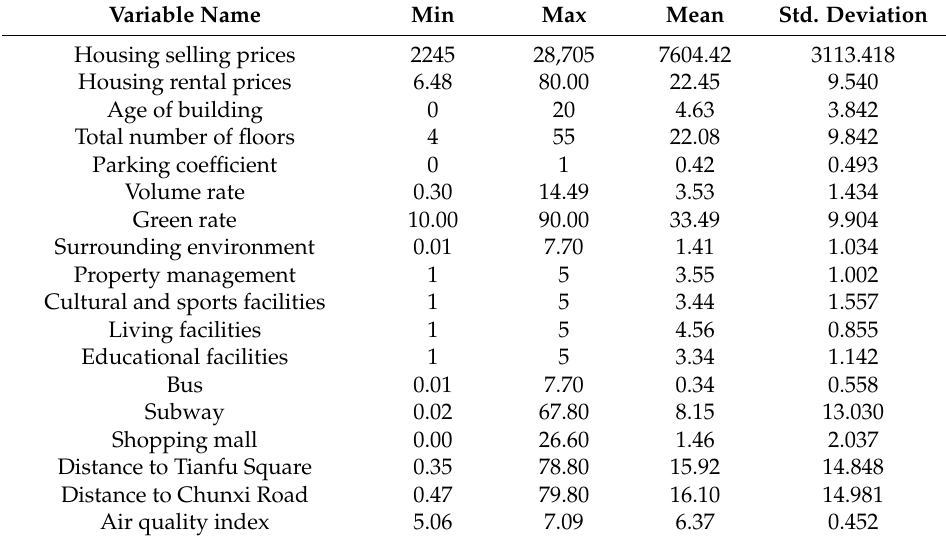
Table 3. Descriptive statistical